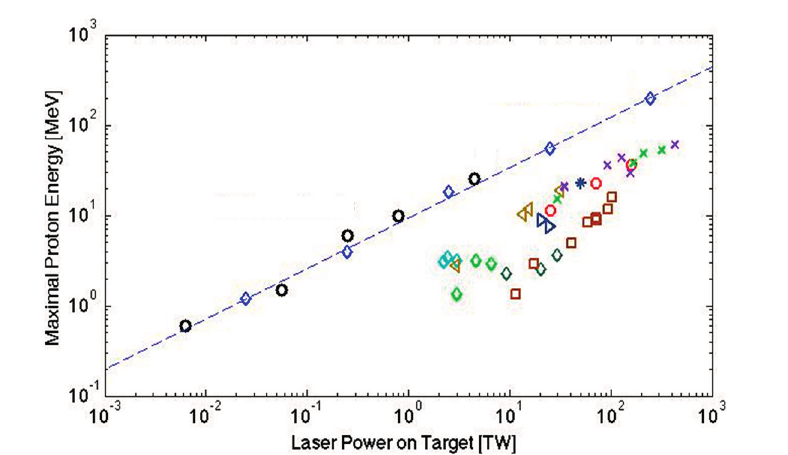
Figure 1. Energy scaling of the accelerated protons as a function of the laser power on target. The various points describe data obtained by many contributors (reproduced from [19]), the experimental results obtained with snow targets are marked by black circles. Results of PIC simulations are marked by blue diamonds (Reproduced with permission from [16]; published by American Physical Society,